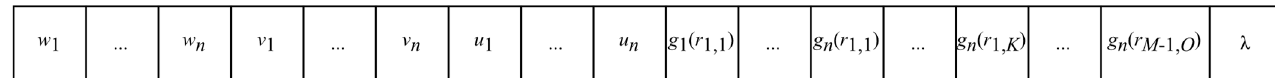
Figure 3. Individuals used in the genetic algorithm to represent nC inf .